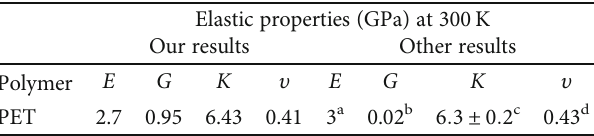
Table 2: Young ’ s modulus ( E ), shear modulus ( G ), bulk modulus ( K ), and Poisson ’ s ratio ( υ ) at 300 ° K of PET. Elastic properties (GPa) at 300 K Our results Other